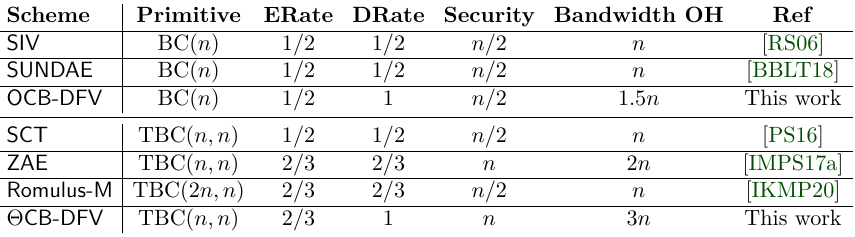
Table 1: Comparison of MRAE schemes. BC( n ) (TBC( t, n )) denotes n -bit block cipher ( t -bit effective tweak and n -bit block TBC). ERate ( DRate ) denotes the encryption (decryption) rate for messages. Bandwidth OH denotes the overhead of bandwidth in bits. Security denotes the MRAE advantage in bits. For OCB-DFV we assume n/ 2-bit